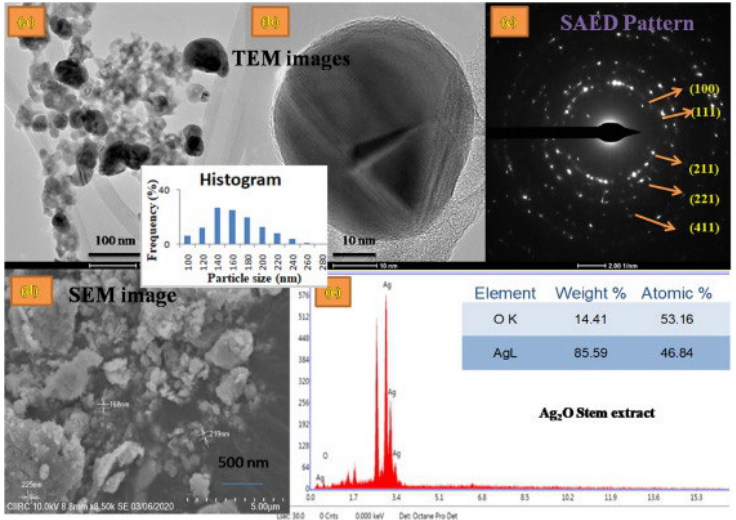
Figure 4. ( a ) TEM image and Histogram, ( b ) Magnified TEM image, ( c ) SAED pattern, ( d ) SEM, ( e ) EDS profile of the Ag 2 O–NPs samples prepared using Thunbergia mysorensis stem extract. Reprinted with permission from Ref. [41] Copyright 2022 Elsevier.